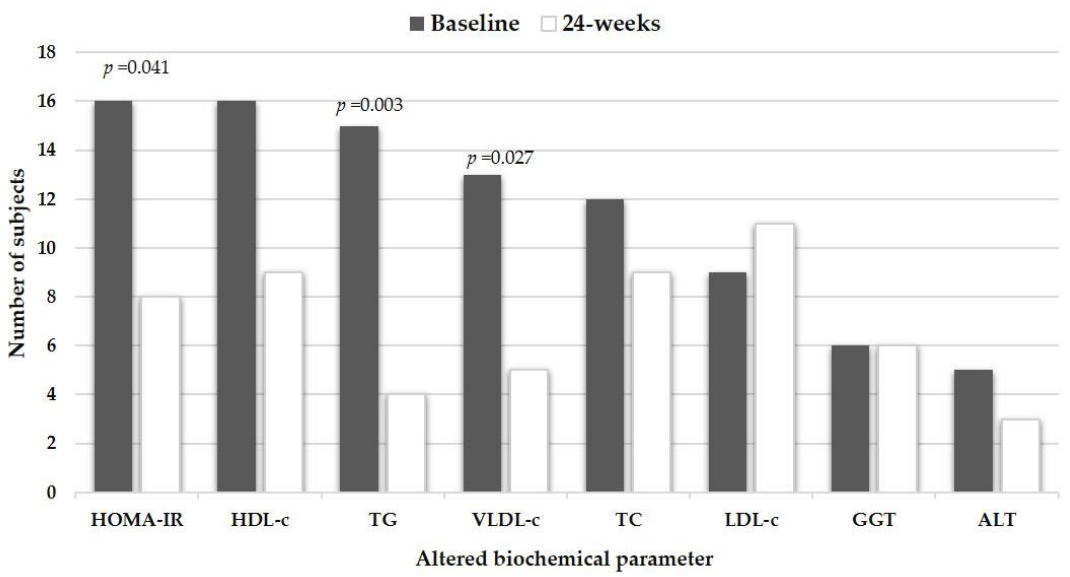
Figure 1. Metabolic disturbances in 33 study subjects before and after dietary intervention with a regionalized GENOMEX diet. Significant p -values are reported for the baseline vs. post-intervention change in the frequency of subjects with the altered metabolic parameter.